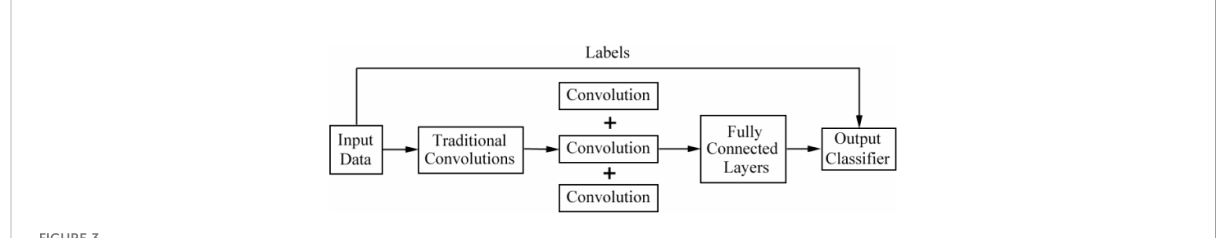
FIGURE 3 Overview of the architecture based on CNNs for DFU image classi fi cation in literature